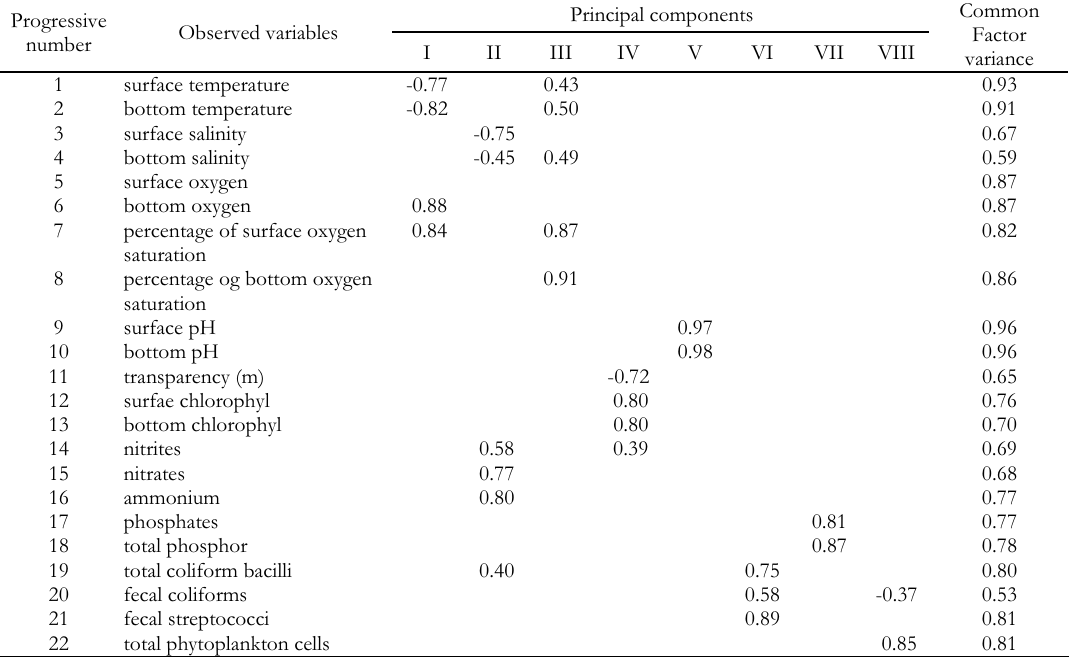
Correlation coefficients between the observed variables and the extracted factors